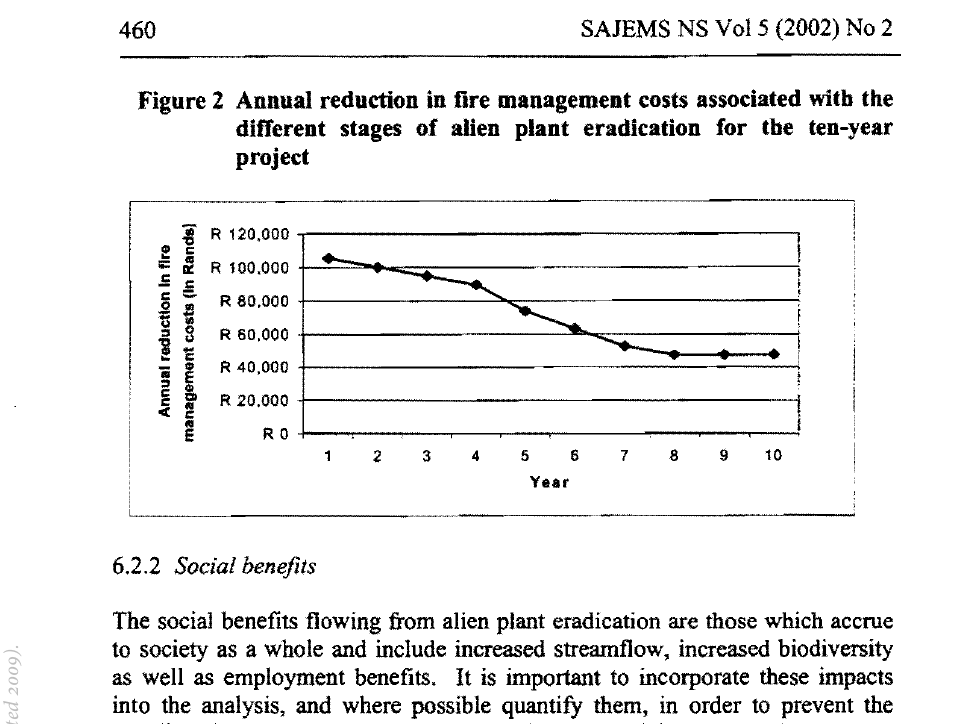
Figure 2 Annual reduction in fire management costs associated witb